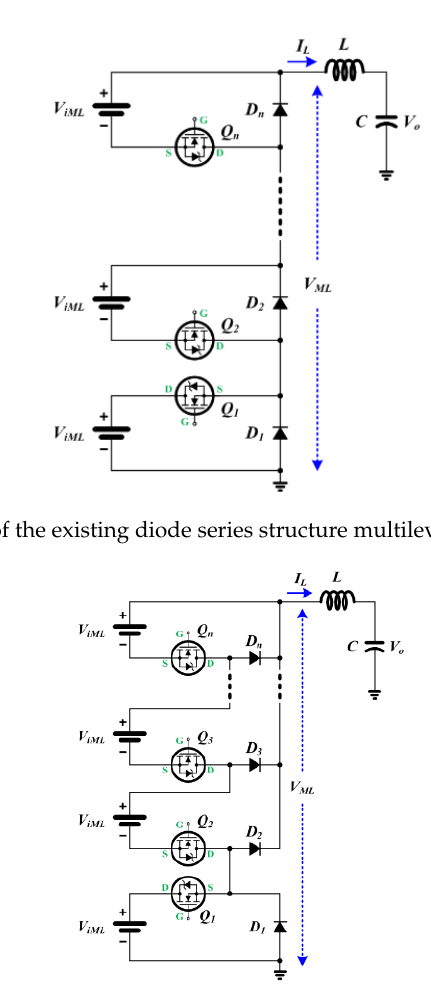
Figure 3. Topology of the proposed diode parallel structure multilevel converter (DPS-MLC).